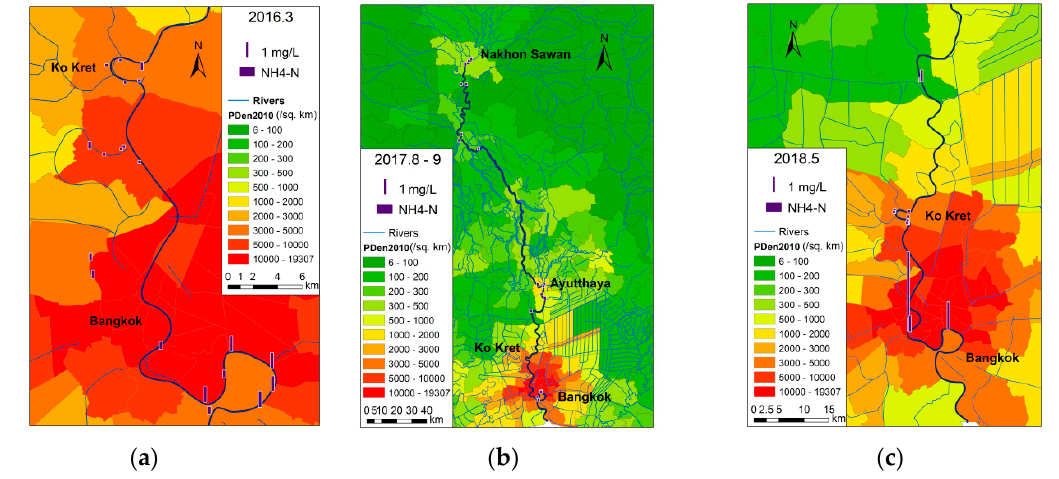
Figure 5. The spatial–temporal variation of NH 4 -N. ( a ) Dry; ( b ) Beginning; ( c ) Second half.